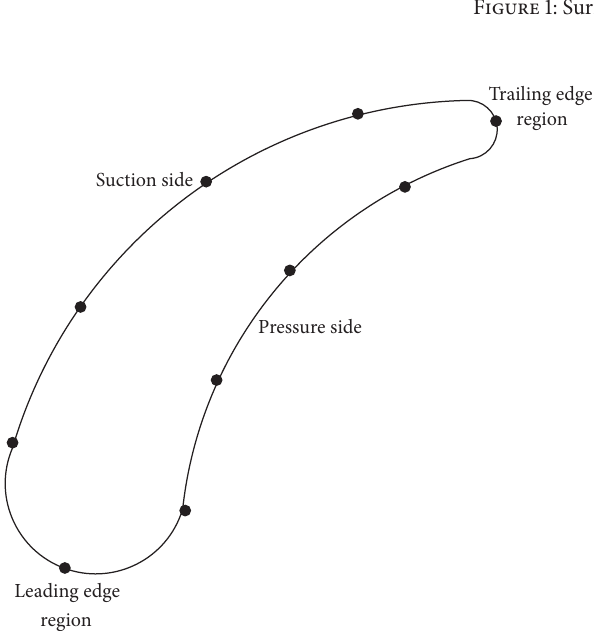
Figure 1: Surface reconstruction.